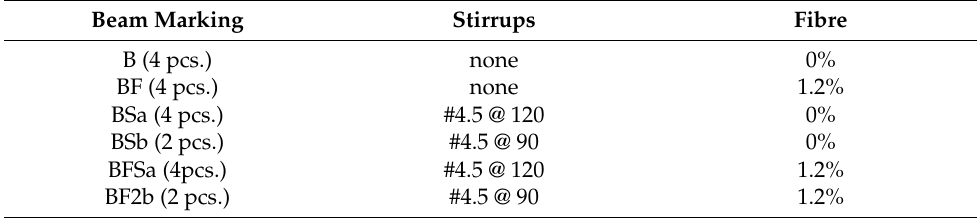
Table 3. Description of the test elements.